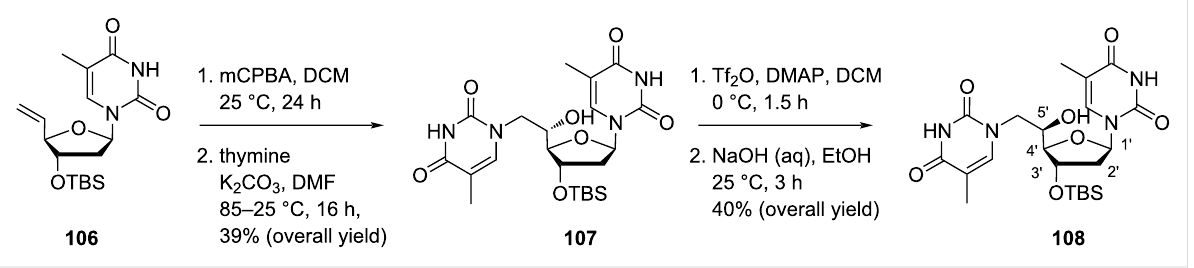
Scheme 24: Synthesis of the double-headed nucleosides 107 and 108 .